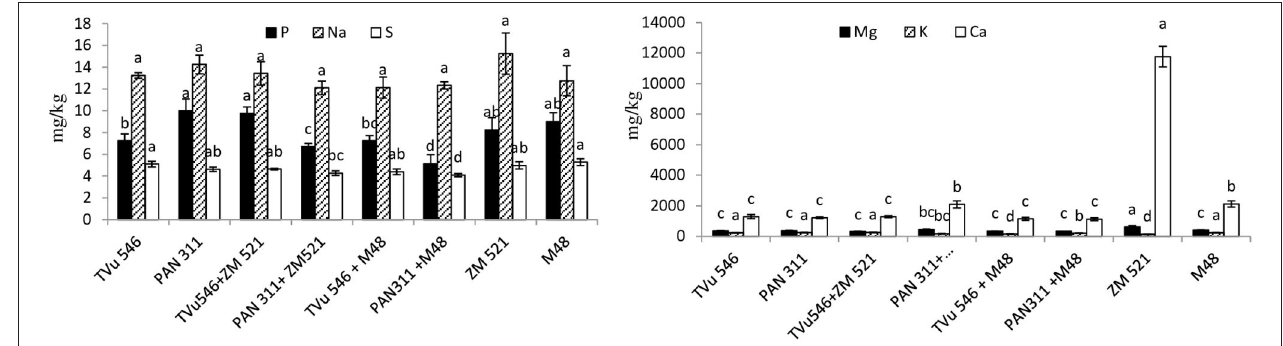
FIGURE 2 | Presence of exchangeable macro-element in rhizosphere of solo and intra-hole planted cowpea, sorghum, and maize. Bars with dissimilar letters are significantly different ( P ≤ 0.05) for each